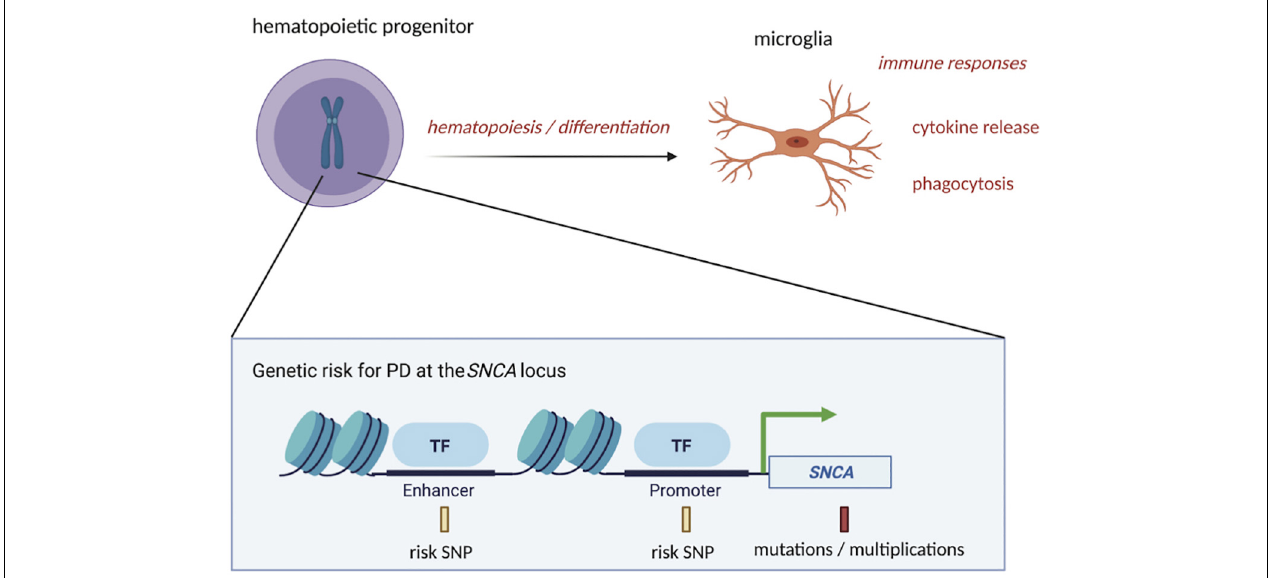
FIGURE 1 | PD-associated genetic variation at the SNCA locus could affect microglia function at the precursor and mature stages. PD risk SNPs in regulatory regions of DNA, such as enhancers and promoters at the SNCA locus, along with more highly penetrant mutations or multiplications in SNCA coding regions, could impact the process of differentiation of hematopoietic precursors into mature microglia. Once differentiated, microglia’s functions, such as cytokine release and phagocytosis, could also be influenced by these genetic risk factors, contributing to initiation or progression of PD starting from the time of conception. This figure was created with